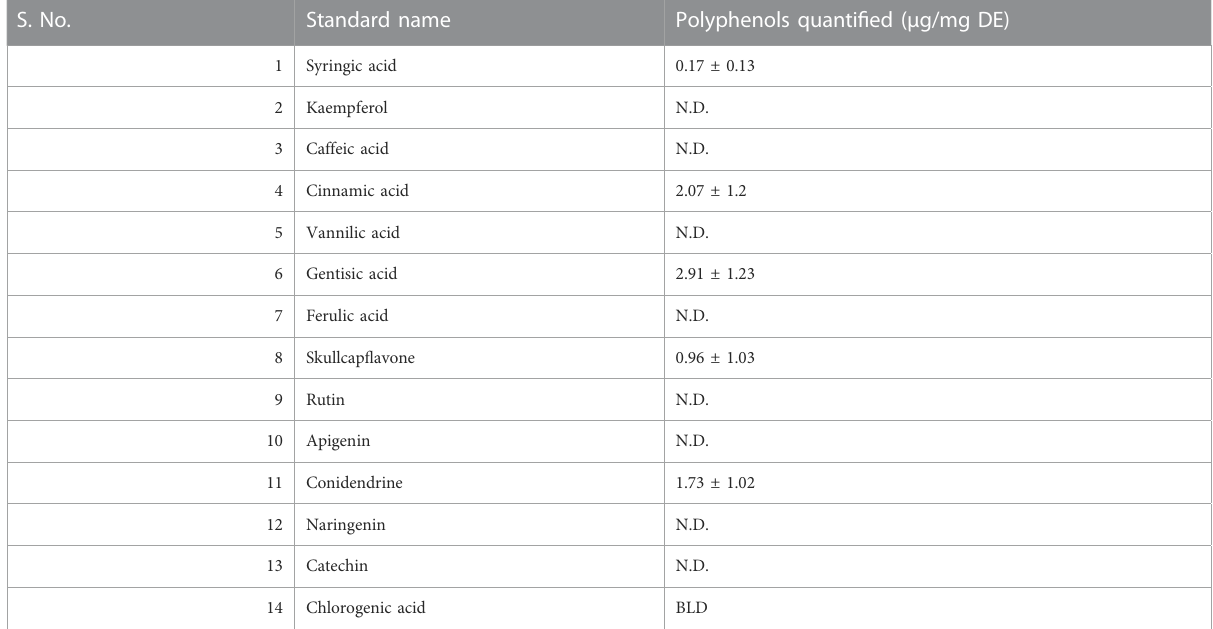
TABLE 3 Polyphenolic compounds quanti fi ed in HAECA. S. No.